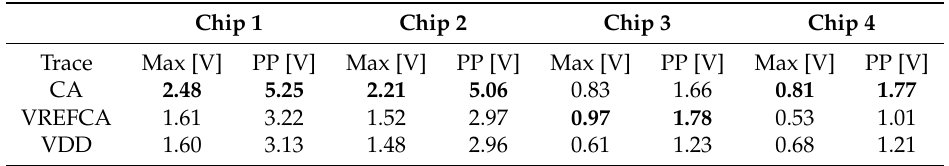
Figure 12. Comparison of induced voltages with respect to net and chip positions for each memory module: ( a ) DDR3; and ( b ) DDR4. Table 3. Induced voltages across all nets around each chip of DDR3 module (see waveform in Figure 12a) (bold depicts the sensitive net around each chip position).